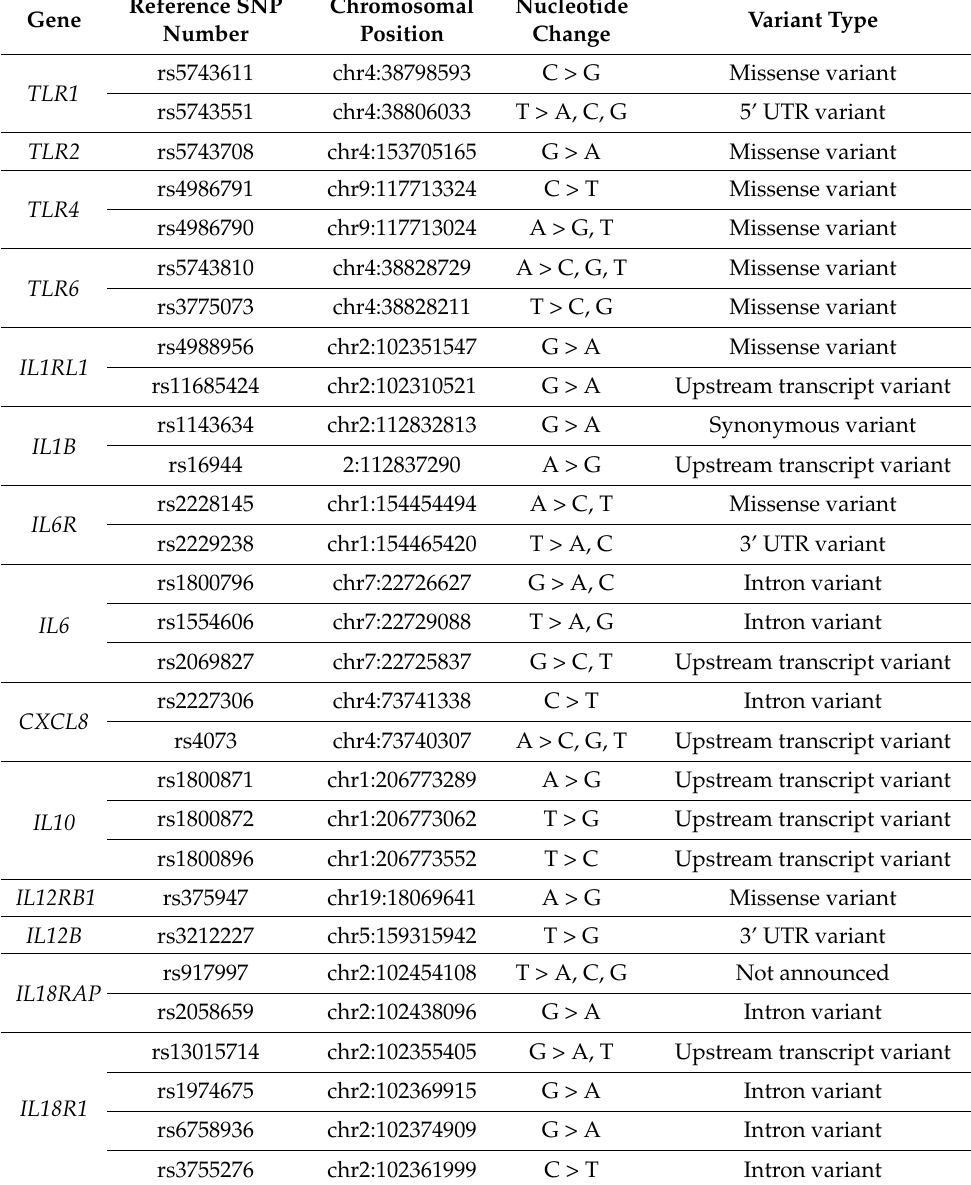
Table 2. Characteristics of the studied polymorphic